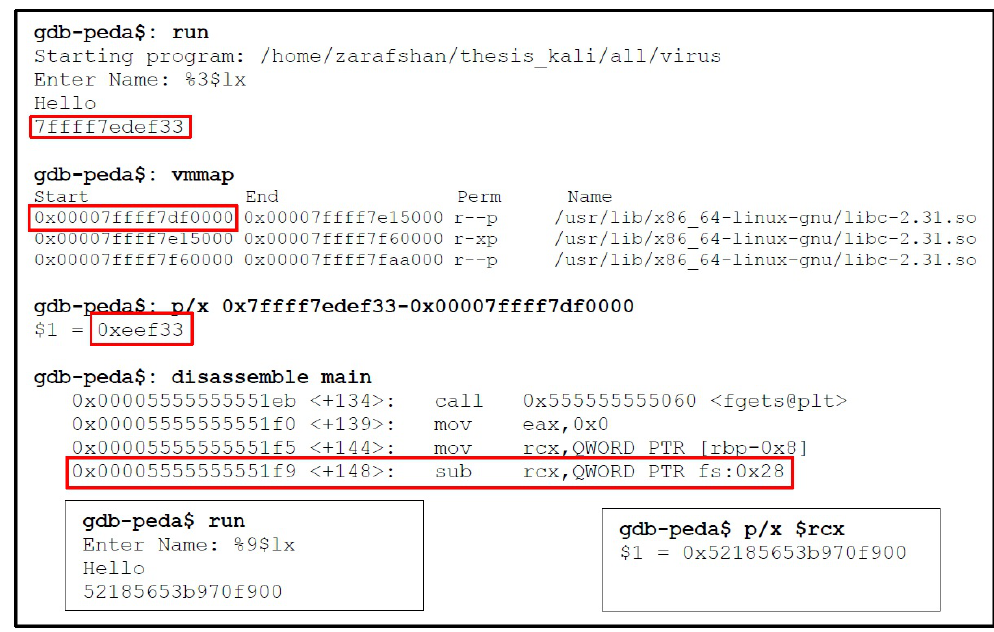
Figure 32. Program Compilation and Information leakage.